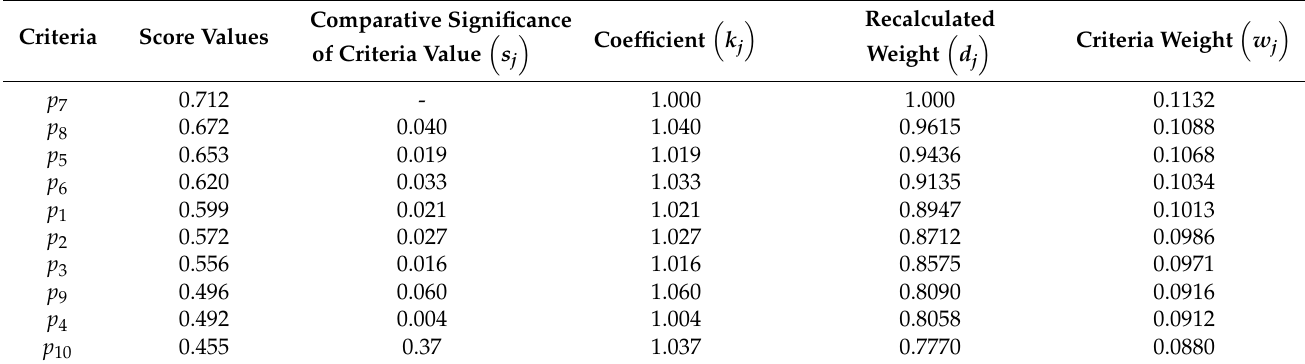
Table 10. Obtained outcomes by SWARA technique for RESs assessment.